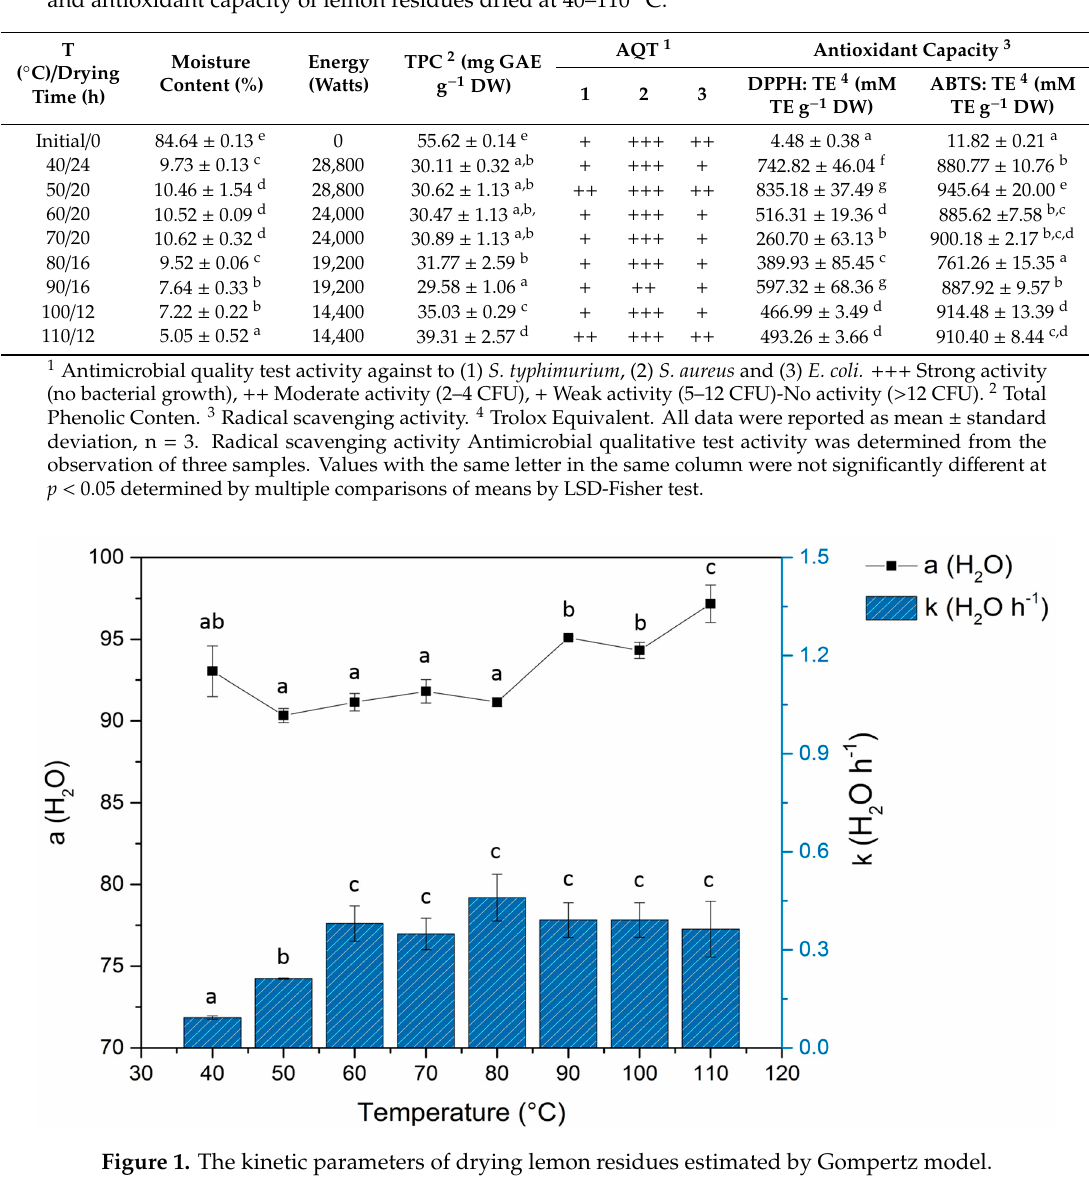
Table 1. Moisture content (%), total phenolic content (TPC), antimicrobial qualitative test activity (AQT) and antioxidant capacity of lemon residues dried at 40–110 °C.